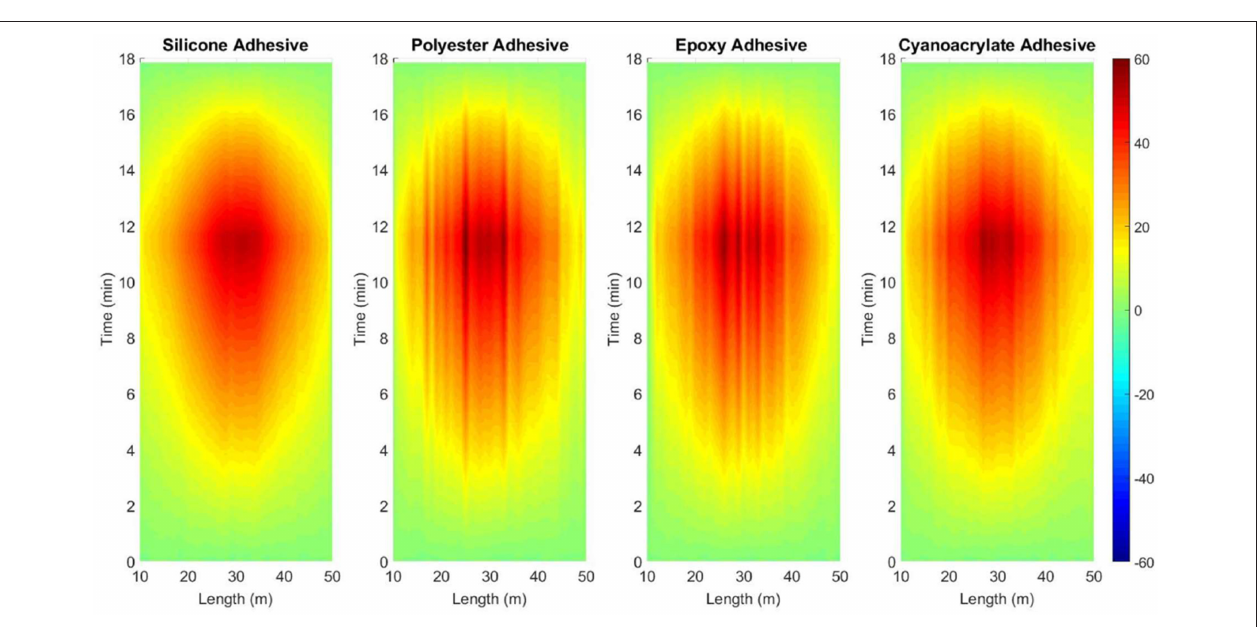
FIGURE 10 | Measured strain by the four different bonded segments under elastic